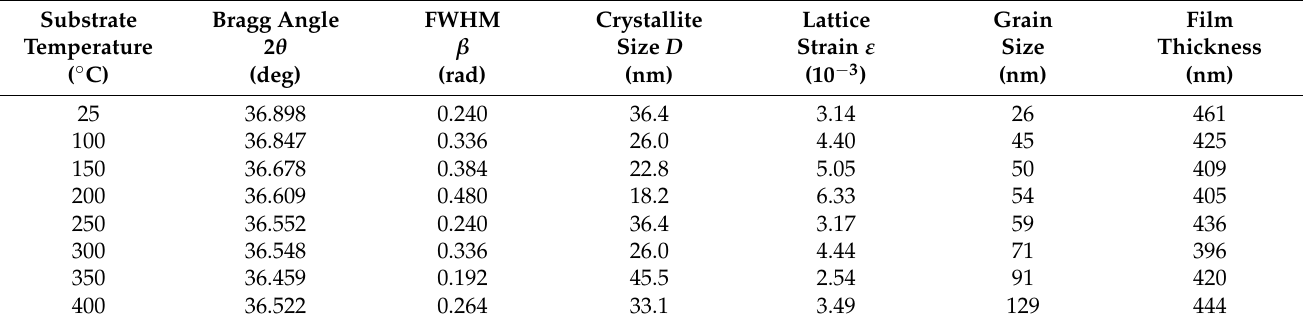
Figure 1. XRD analysis results of Cu 2 O thin films grown at various substrate temperatures; ( a ) diffraction patterns measured with 2 θ angle ranging from 25 ◦ to 80 ◦ ; and ( b ) detailed move- ment status of diffraction peaks for the (111) and (200) planes. Table 1. The crystallite size (determined via XRD), lattice strain (determined via XRD), grain size (determined from FE-SEM images), and thickness (determined from FE-SEM images) of Cu 2 O thin films grown at various substrate temperatures.